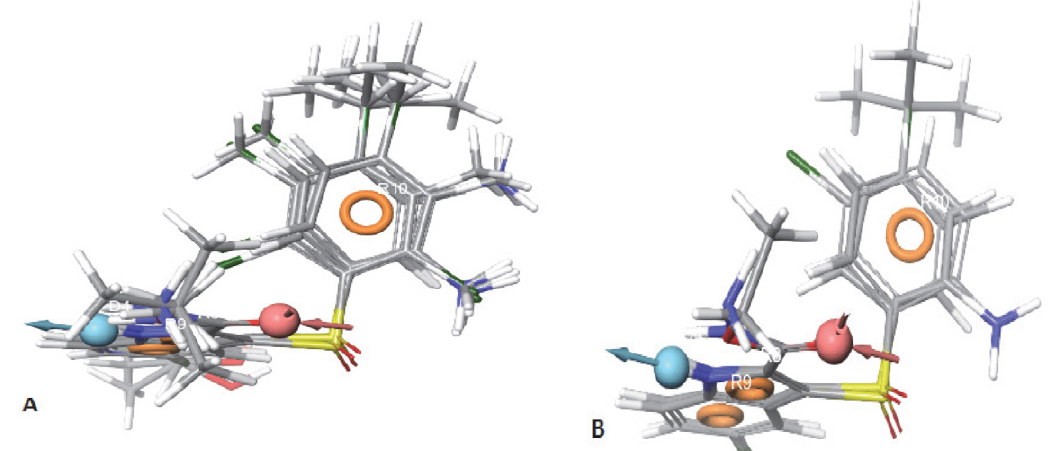
Fig. 4. (A) Mapping of the active compounds onto the pharmacophore. (B) Mapping of inactive compounds on to the pharmacophore.